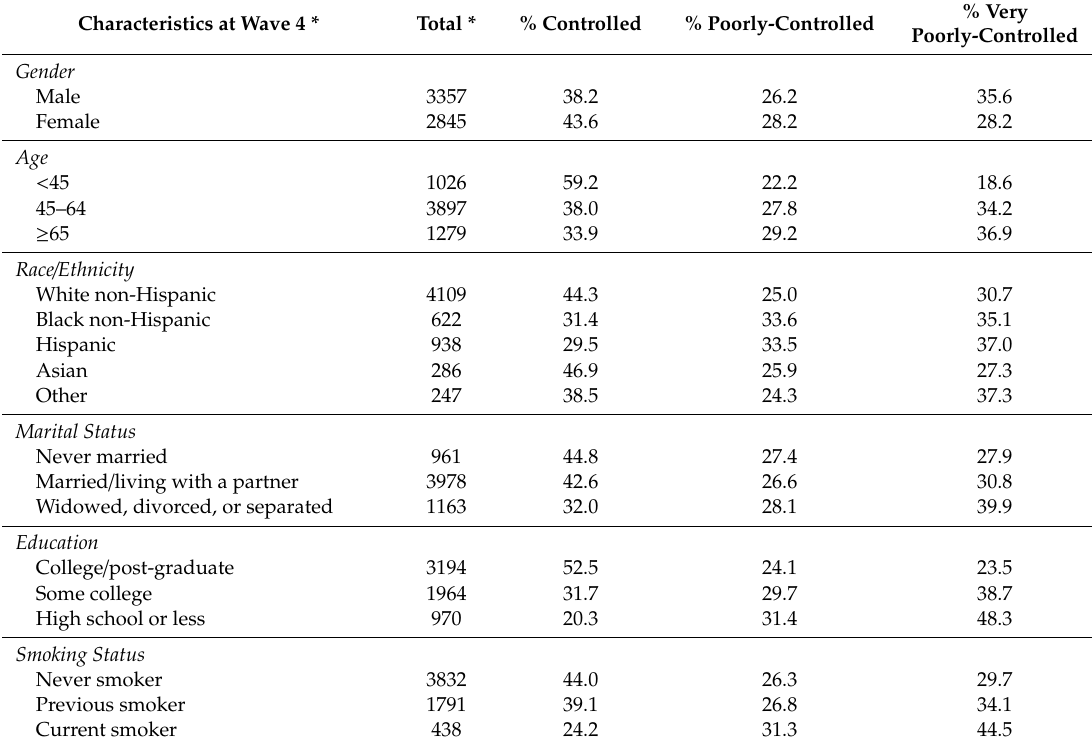
Table 1. Prevalence of asthma control by sociodemographic, air pollution / irritants, and World Trade Center (WTC) dust cloud exposure among 9 / 11-exposed individuals with asthma ( N =